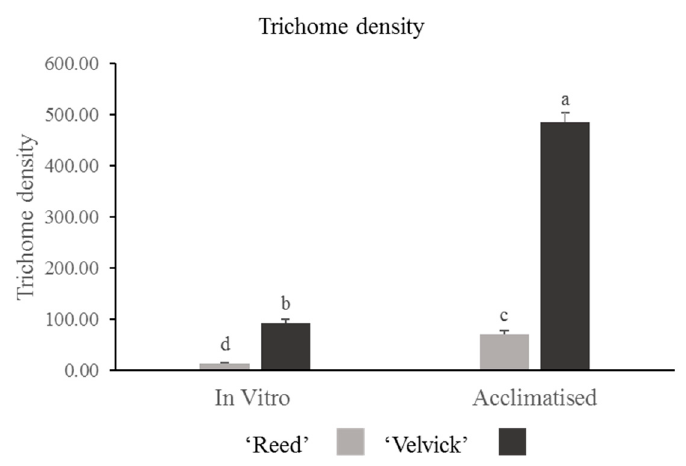
Figure 6. Trichomes were more abundant on lower epidermis of ‘Velvick’ than in ‘Reed’. Lower epidermis of the 3rd fully expanded leaf of in vitro cultured plantlets of ‘Reed’ ( a – c ) and ‘Velvick’ ( d – f ) at different stages, in vitro shoot before rooting ( a , d ), 5 days after de-flasking in water before acclimation ( b , e ) and 1 month in acclimation ( c , f ) were sampled ( n = 5) to observe trichomes.